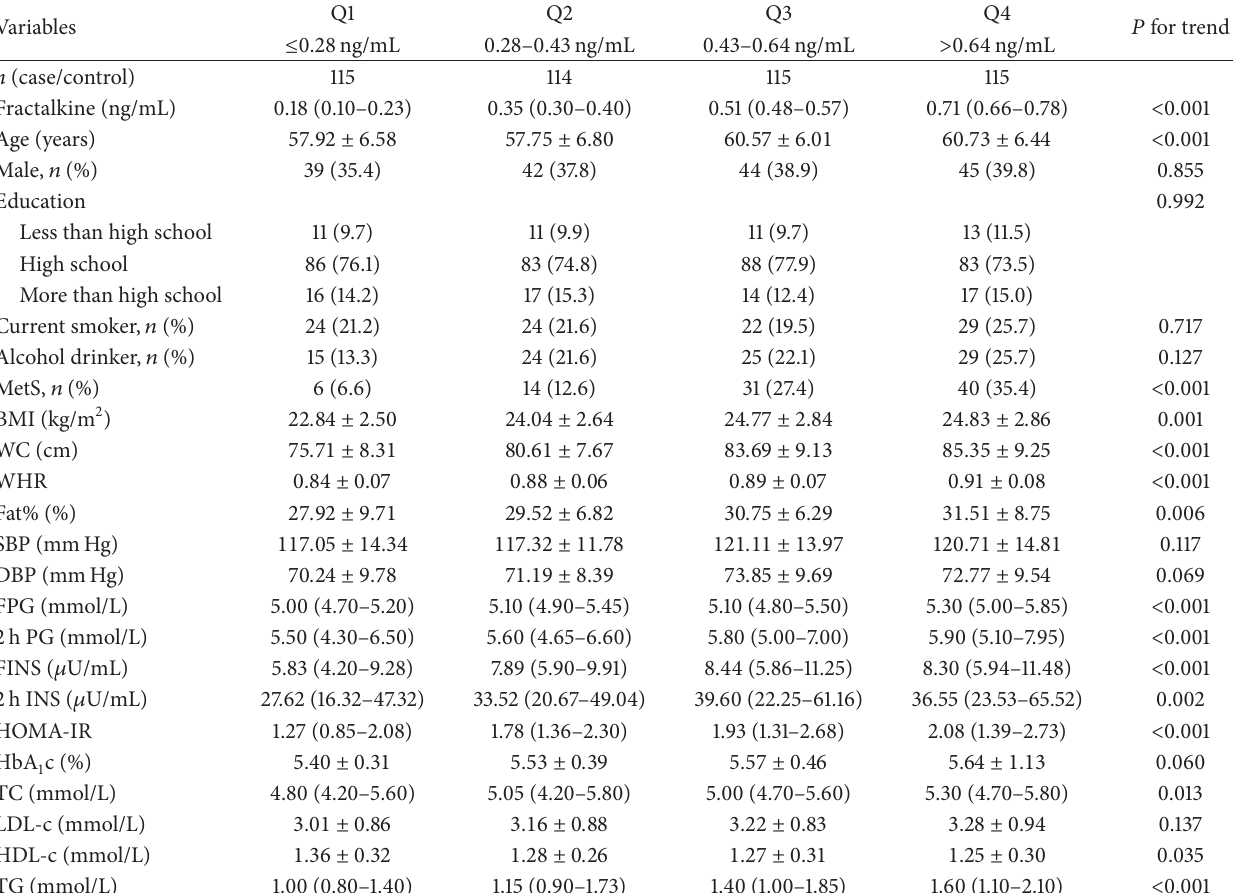
Table 3: Association of baseline fractalkine concentrations with metabolic parameters at year 2 ( 𝑛 = 459 ).